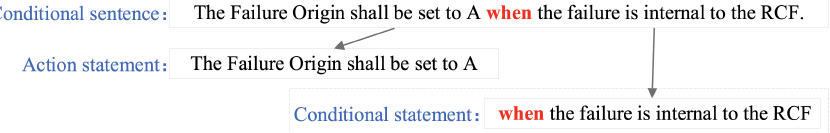
Figure 2. An example of a conditional sentence segmentation.